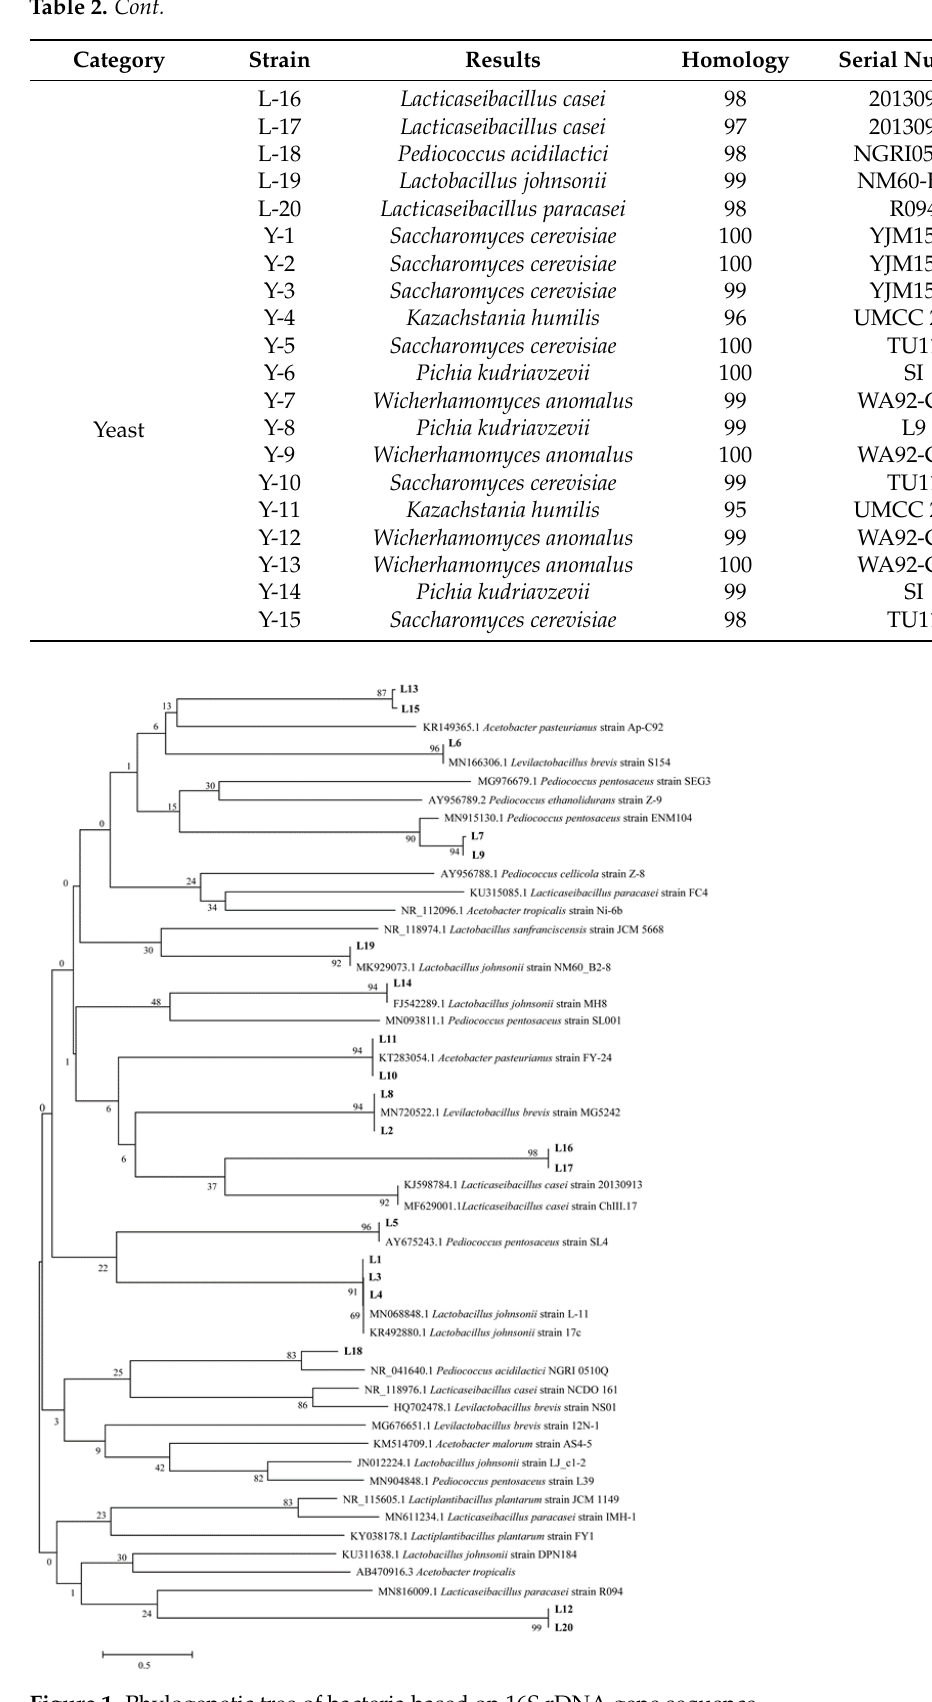
Figure 1. Phylogenetic tree of bacteria based on 16S rDNA gene sequence.